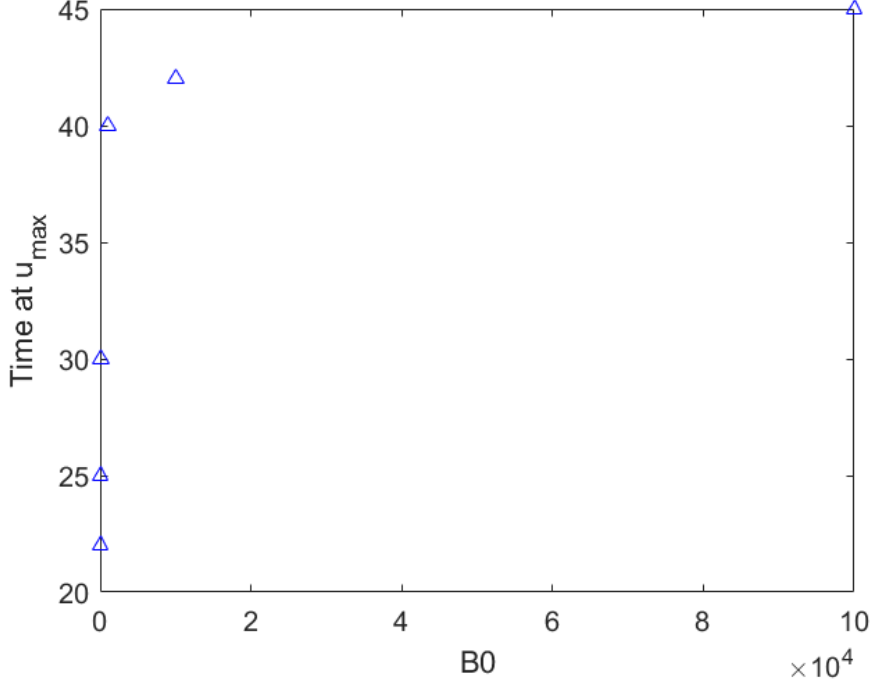
Figure 6. The max t time of Policy 1 against the changes in 0 B of Equation (15). Figure 6. The t max time of Policy 1 against the changes in B 0 of Equation